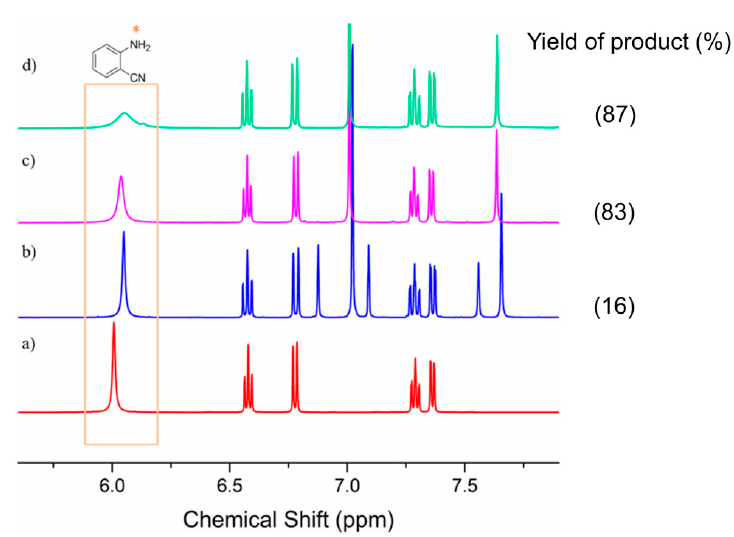
Figure 4. 1 H-NMR spectra of ( a ) 2-aminobenzonitrile with ( b ) [HMIm][Im] (pKa value of cation was 7.1), ( c ) [HDBU][Im] (pKa value of cation was 11.7) or ( d ) [HMTBD][Im] (pKa value of cation was 13.0). The H signal of amino in 2-aminobenzonitrile became broader when the basicity of cation was higher. Reprinted with permission from [81] (Copyright 2018 American Chemical Society).